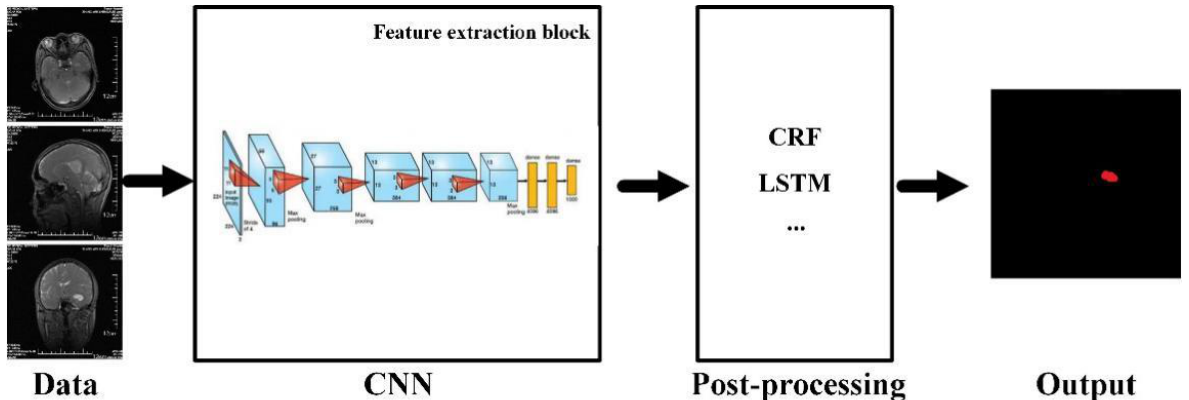
Figure 19. The basic method of MRI brain tumor segmentation based on CNN.